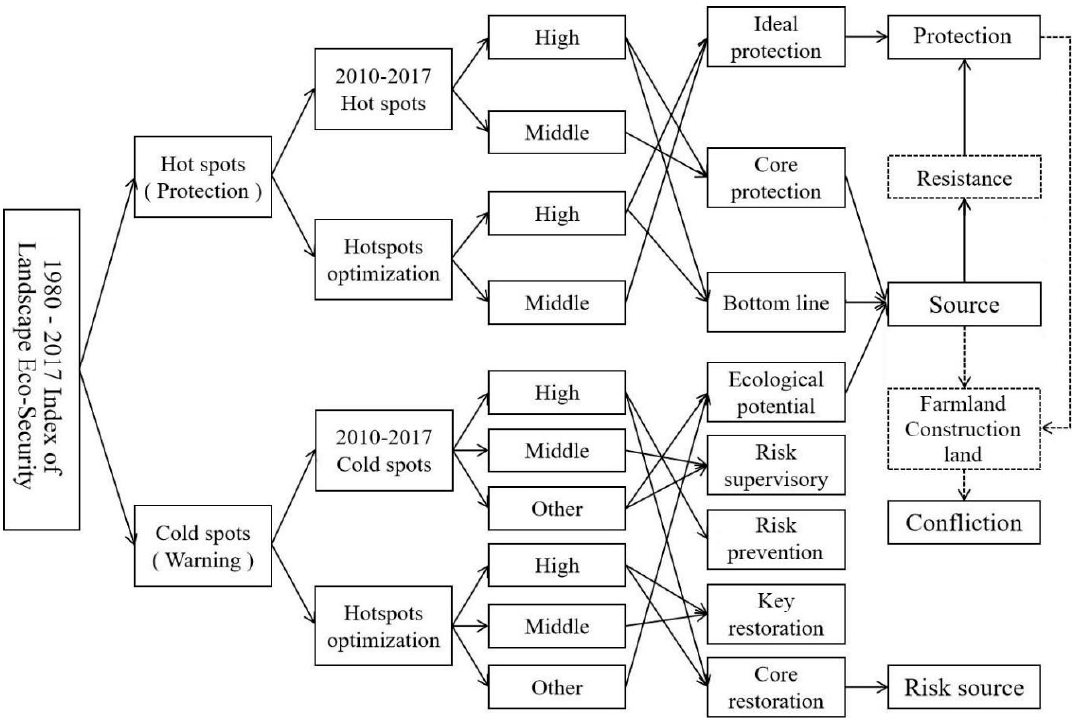
Figure 5. Partitioning standards.